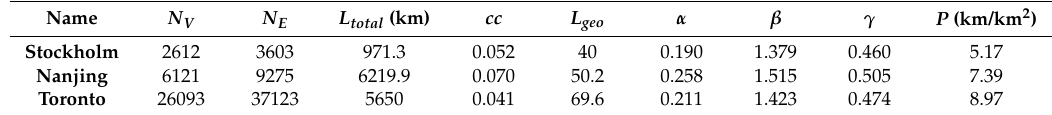
Table 2. Basic planar statistics of three cities.